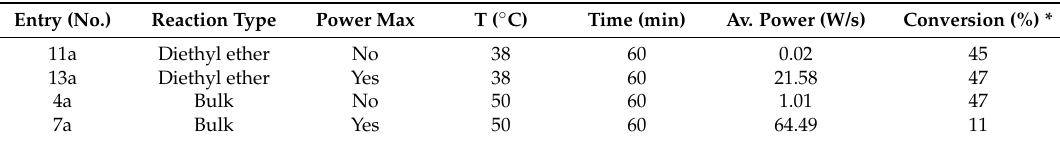
Table 3. Comparison of average power over 60 min for bulk and organic media reactions with or without Power Max of DMS with BDO.